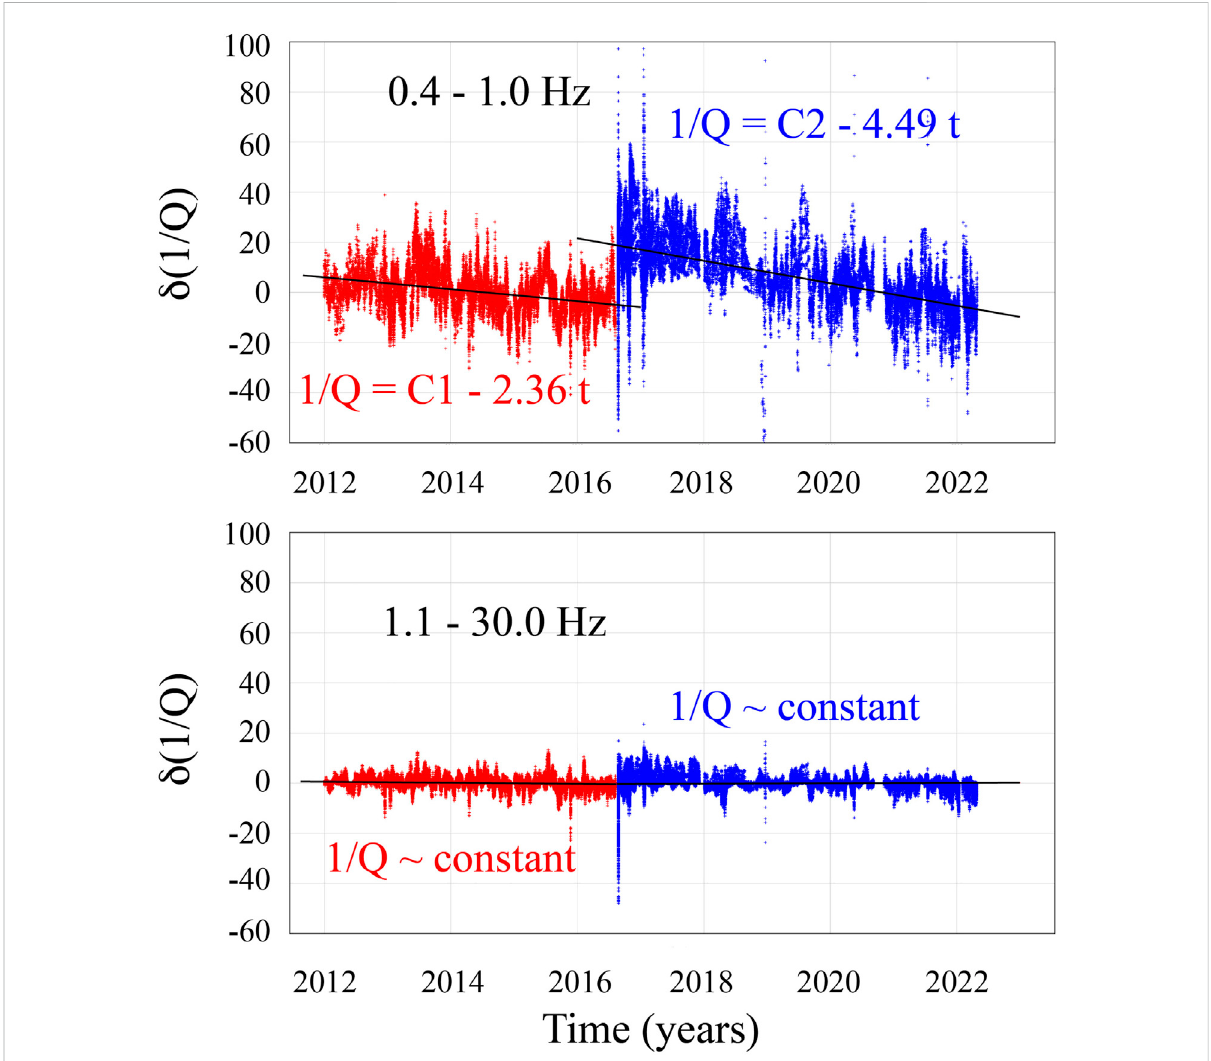
FIGURE 7 Upper : fl uctuation of δ ( Q − 1 S ( t , f )) in the 0.4 – 1.0 Hz frequency band. Lower : fl uctuation of δ ( Q − 1 S ( t , f )) in the 1.1 – 30.0 Hz frequency band. Red: 01/01/2012 – 23/08/2016(beforeAmatrice);Blue;24/08/2016 – 05/05/2022(afterAmatrice).Inbothframes,blacklinesindicatestheresultsoflinear regressions. At higher frequencies, Q − 1 S ( t , f ) is practically constant in the entire time window (2012 –